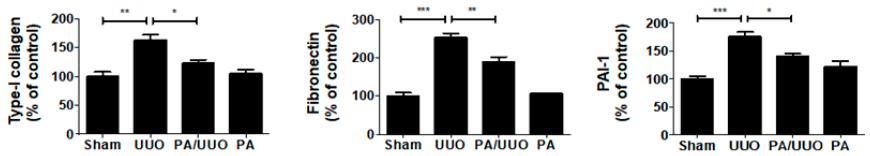
Figure 2. PA suppresses collagen and extracellular matrix (ECM) accumulation in UUO mice. ( a ) The kidney sections are stained with Masson’s trichrome, which accentuates interstitial fibrosis by staining the collagen blue. Scale bar 50 μ m. The semi-quantitative analysis of collagen blue areas of the obstructed kidney in each group. These are representative images from each study group. ( b ) Immunoblot results show the effects of PA on ECM accumulation in UUO mice. β -Actin was used to